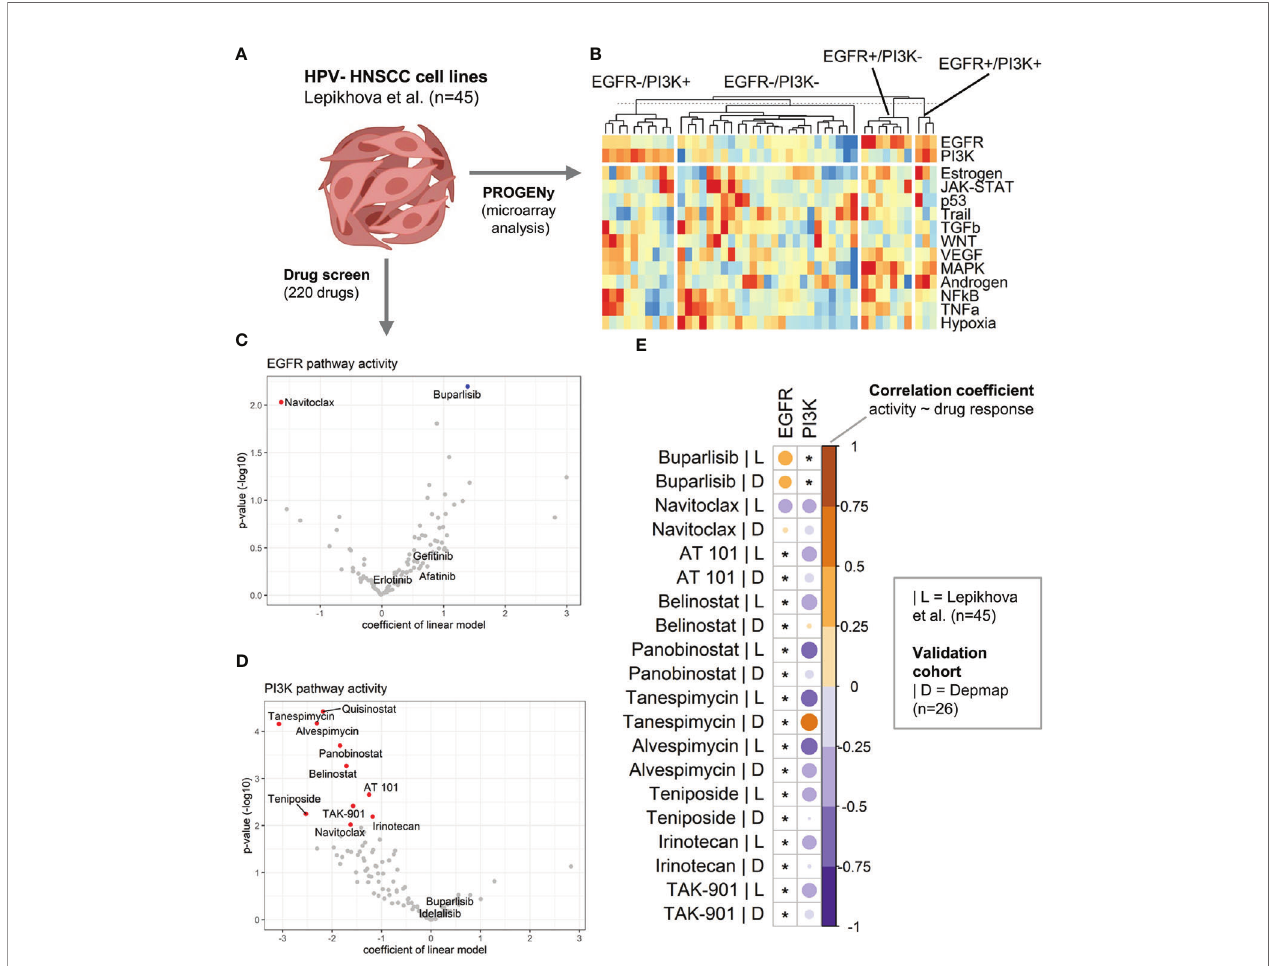
FIGURE 3 | Drug sensitivity analysis in HNSCC cell line models of EGFR and PI3K pathway activation. (A) Transcriptomic and drug screen data of 45 HPV-HNSCC cell lines published by Lepikhova et al. was used. Created with BioRender.com. (B) Heatmap of pathway activity matrix of the HPV-HNSCC cell line cohort (n = 45). Samples were grouped by their EGFR and PI3K pathway activation status. (C, D) Volcano plots of the results from the linear modeling of drug responses for (C) EGFR and (D) PI3K pathway activity. A positive coef fi cient equals a positive association between pathway activity and drug sensitivity. For details regarding the modeling, please refer to the Materials and Methods section. Signi fi cant associations are colored in red (negative) and blue (positive). (E) Validation of the associations between pathway activities and drug responses in an independent validation cohort (DepMap data). The correlation heatmap compares the correlation coef fi cients of the initial cohort (|L = Lepikhova) and the validation cohort (|D = Depmap). An asterix marks associations that have not been signi fi cant in the initial